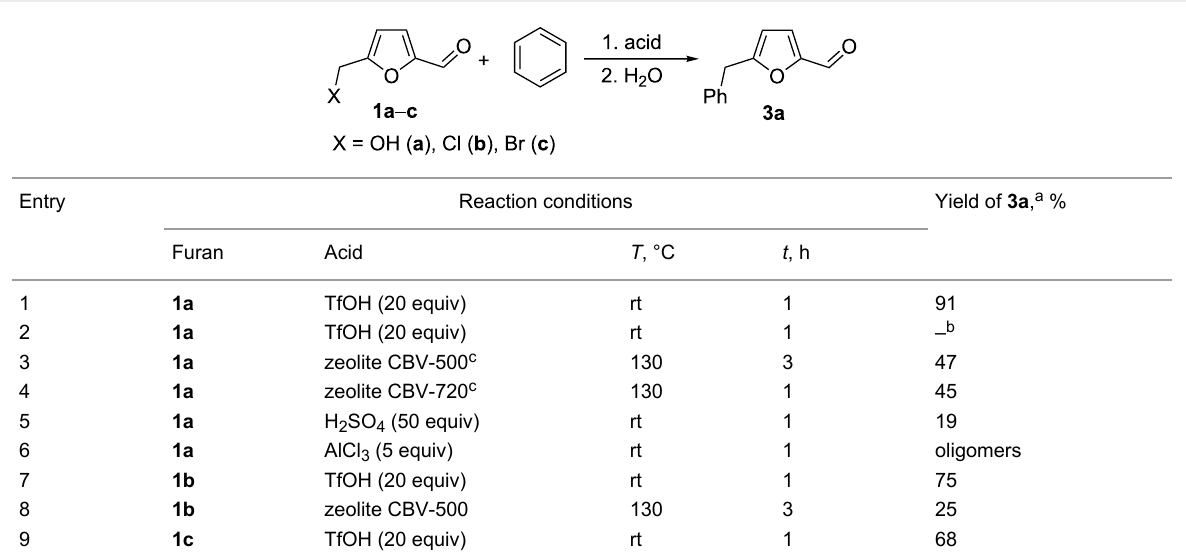
Table 3: Reactions of furans 1a–c with benzene under the action of various acids.